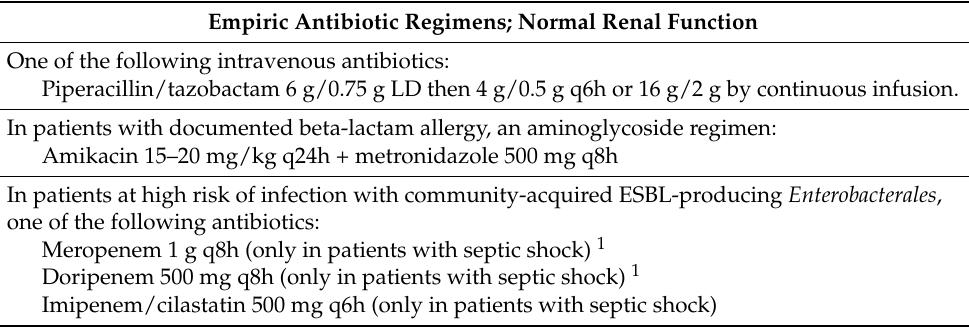
Table 2. Patients with community-acquired intra-abdominal infection with sepsis or septic shock. Empiric Antibiotic Regimens; Normal Renal